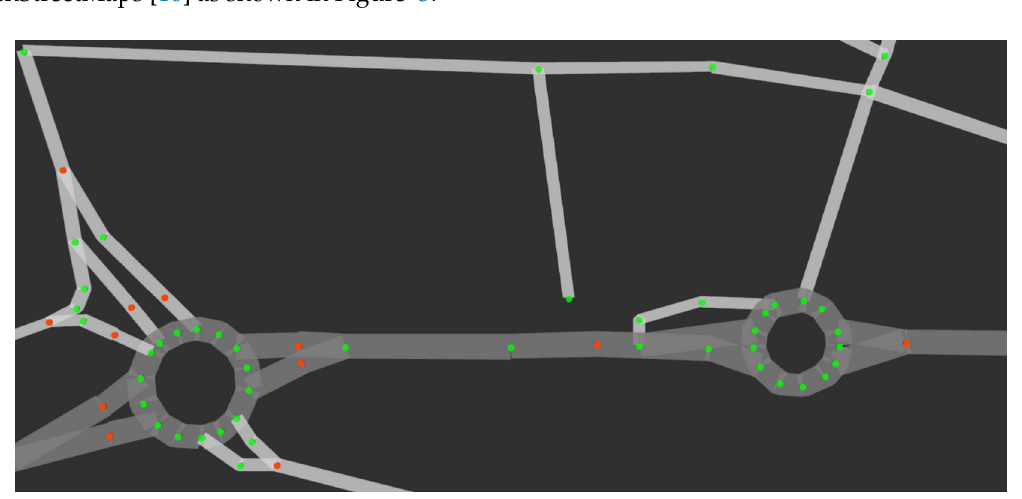
Figure 3. Digital map built from OpenStreetMap